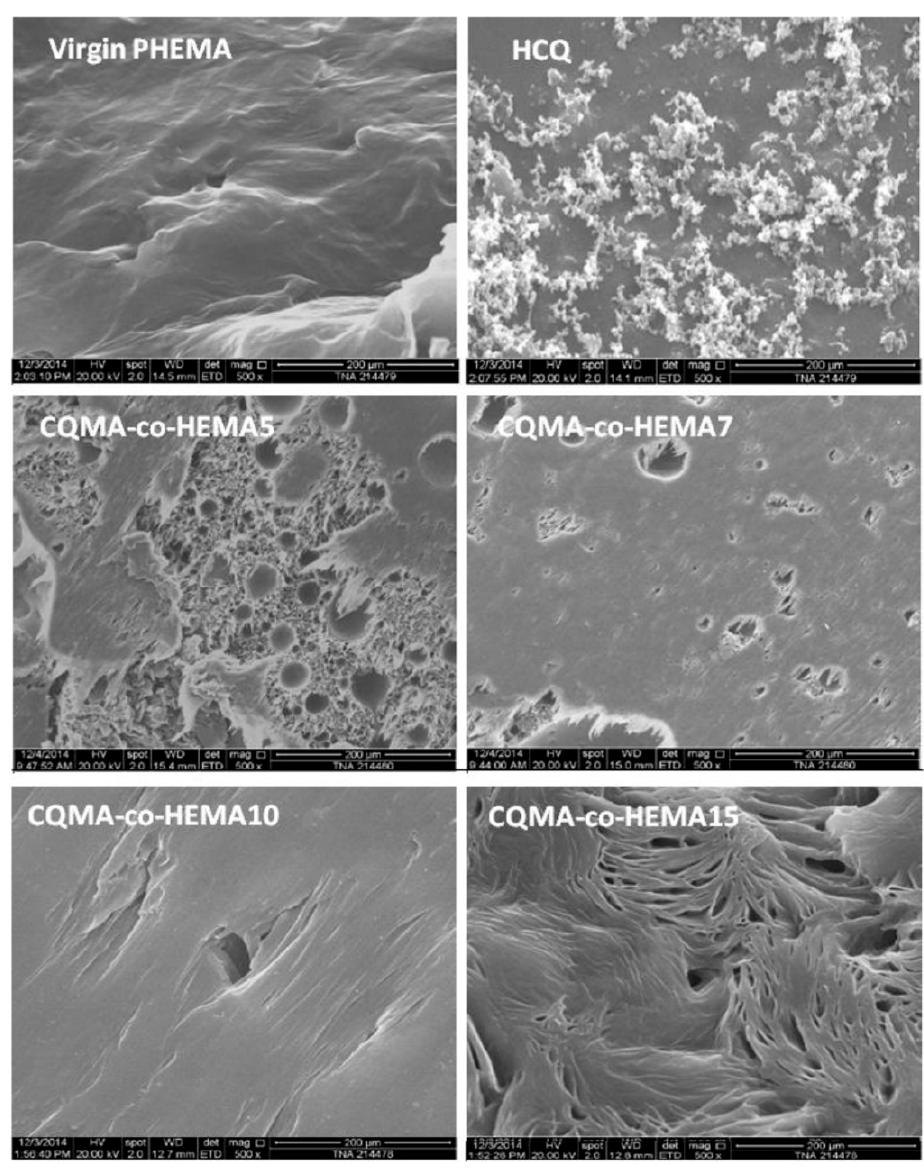
Figure 10. SEM micrographs of HCQ particles, surface morphologies of virgin PHEMA and CQMA- co-HEMA copolymers films.